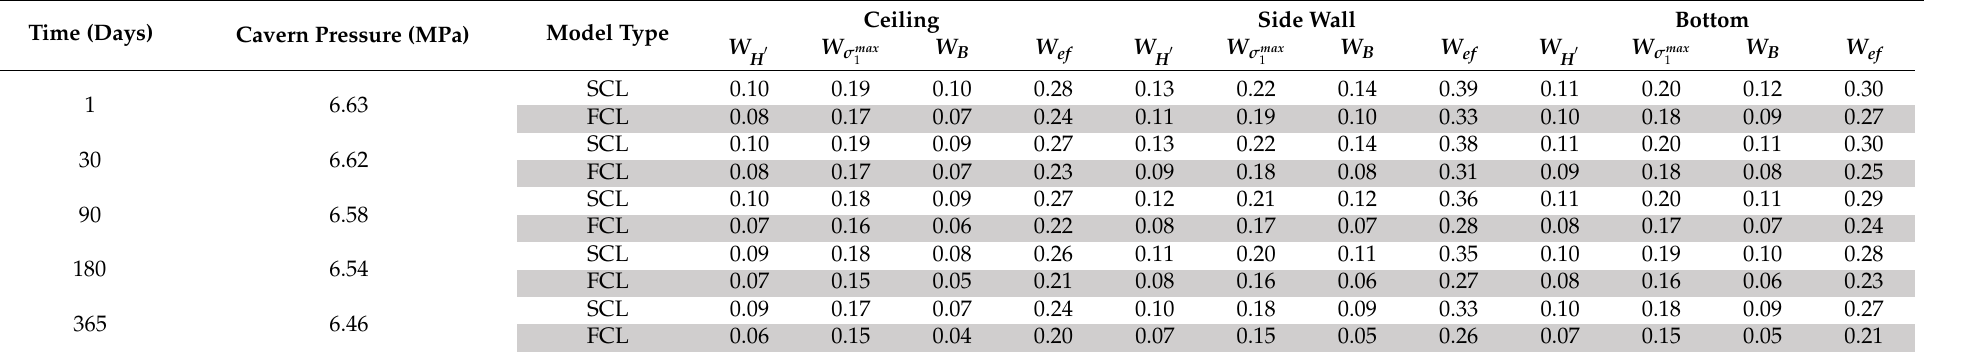
Table A4. Strength criteria for the two salt-creep models. Status at the end of the work cycle (after 8 h of cavern rest at maximum pressure). Time